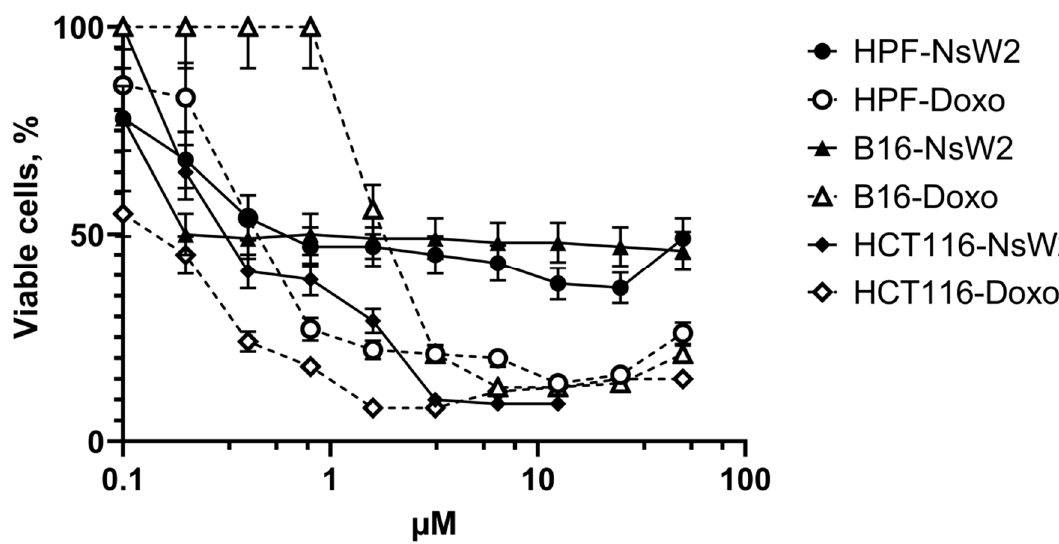
Figure 4. Cytotoxic activity of NsW2 in vitro. Doxorubicin was used as a positive control. Concentration dependence is shown by a solid line with black dots; the activity of doxorubicin is shown by a dashed line with white dots ( ♦ ) HPF cell line; ( ◊ ) HPF cell line with doxorubicin; ( ■ ) B16 cell line with NsW2; ( □ ) B16 cell line with doxorubicin; ( ● ) HTC-116 cell line with NsW2; ( ○ ) HTC-116 cell line with doxorubicin. Error bars represent mean ±S.E. (three independent experiments performed in triplicate).